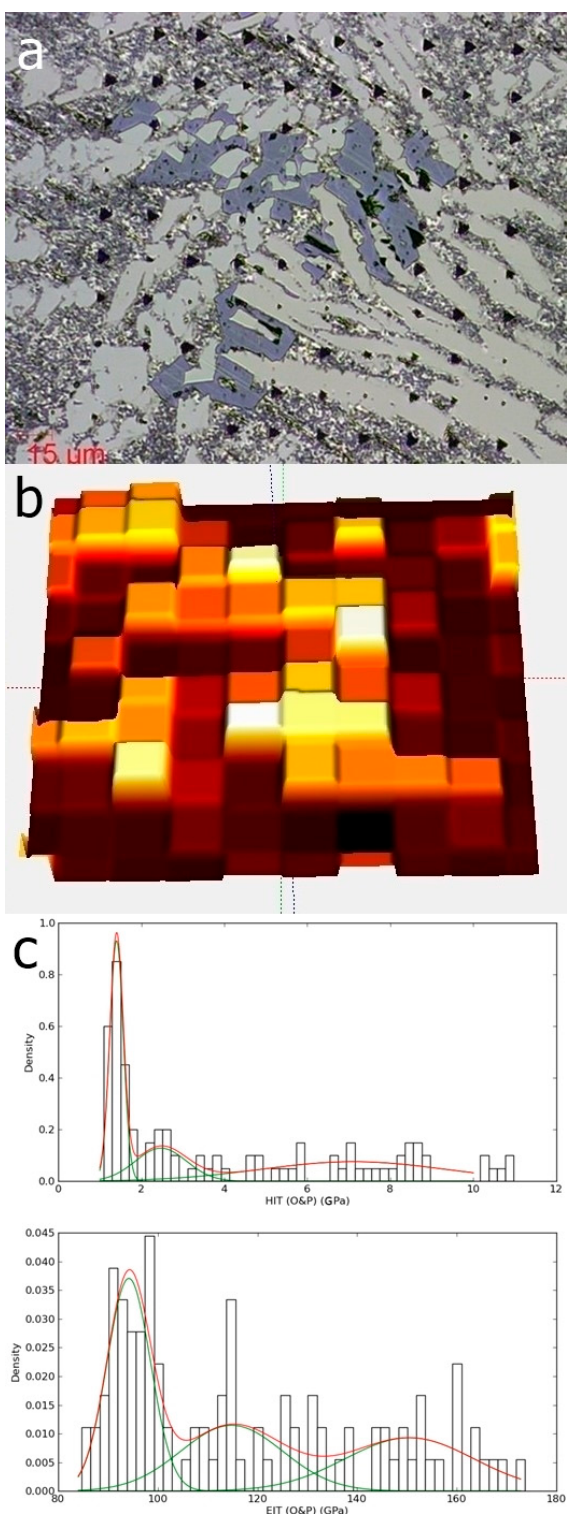
Figure 12. The indentation matrix ( a ) and the surface mapping as function of hardness ( b ); the hardness and elastic modulus distribution ( c ), extracted from the surface mapping, for the Al 79 Si 11 Ni 10 alloy.